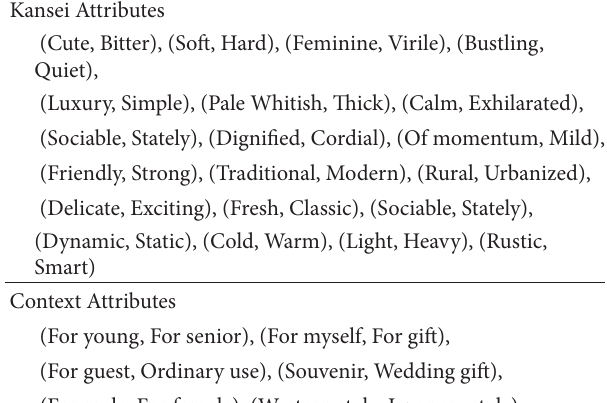
Table 1: Kansei attributes and Context attributes